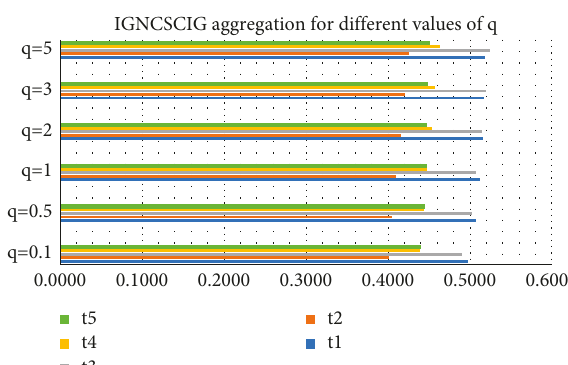
Table 5: The ranking of alternatives subject to the different values of q using the IGNCSCIG operator. Tabulated view of IGNCSCIG for different values of